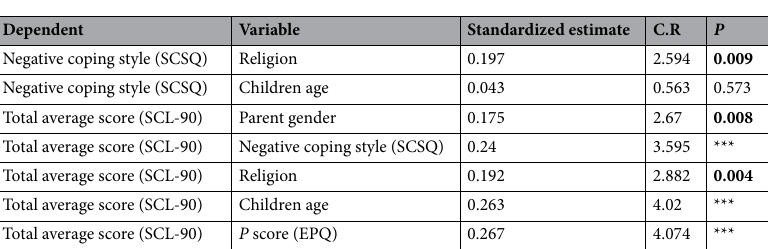
Table 4. Standardized estimates of associations between variables. Significant values are in [bold]. *** P < 0.001.